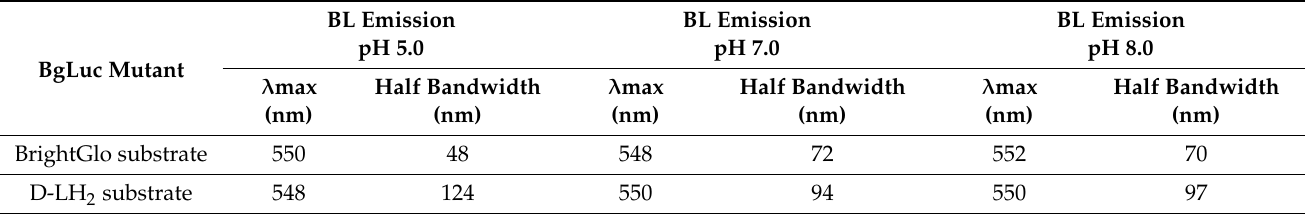
Table 3. λ max and half bandwidth of BgLuc at varying pH